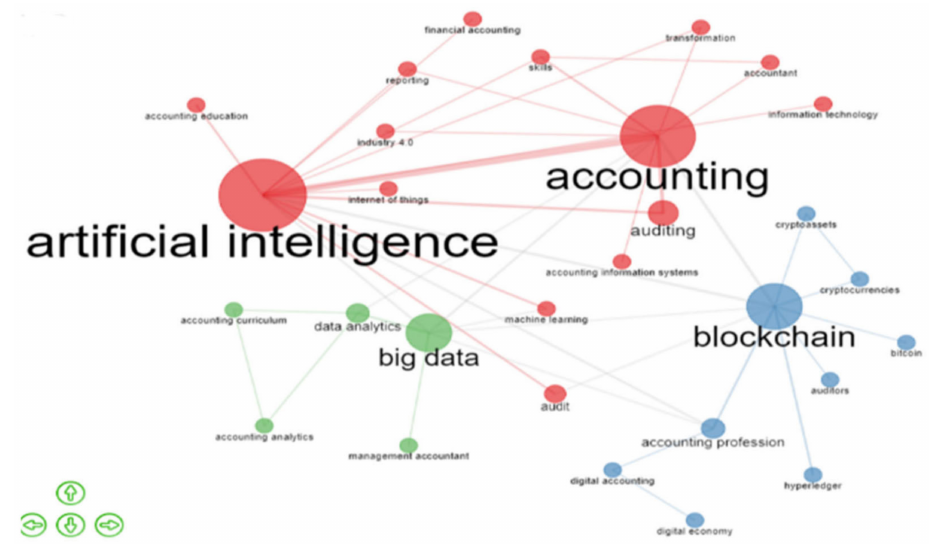
Figure 3. Detailed picture of the relationship between information technology and